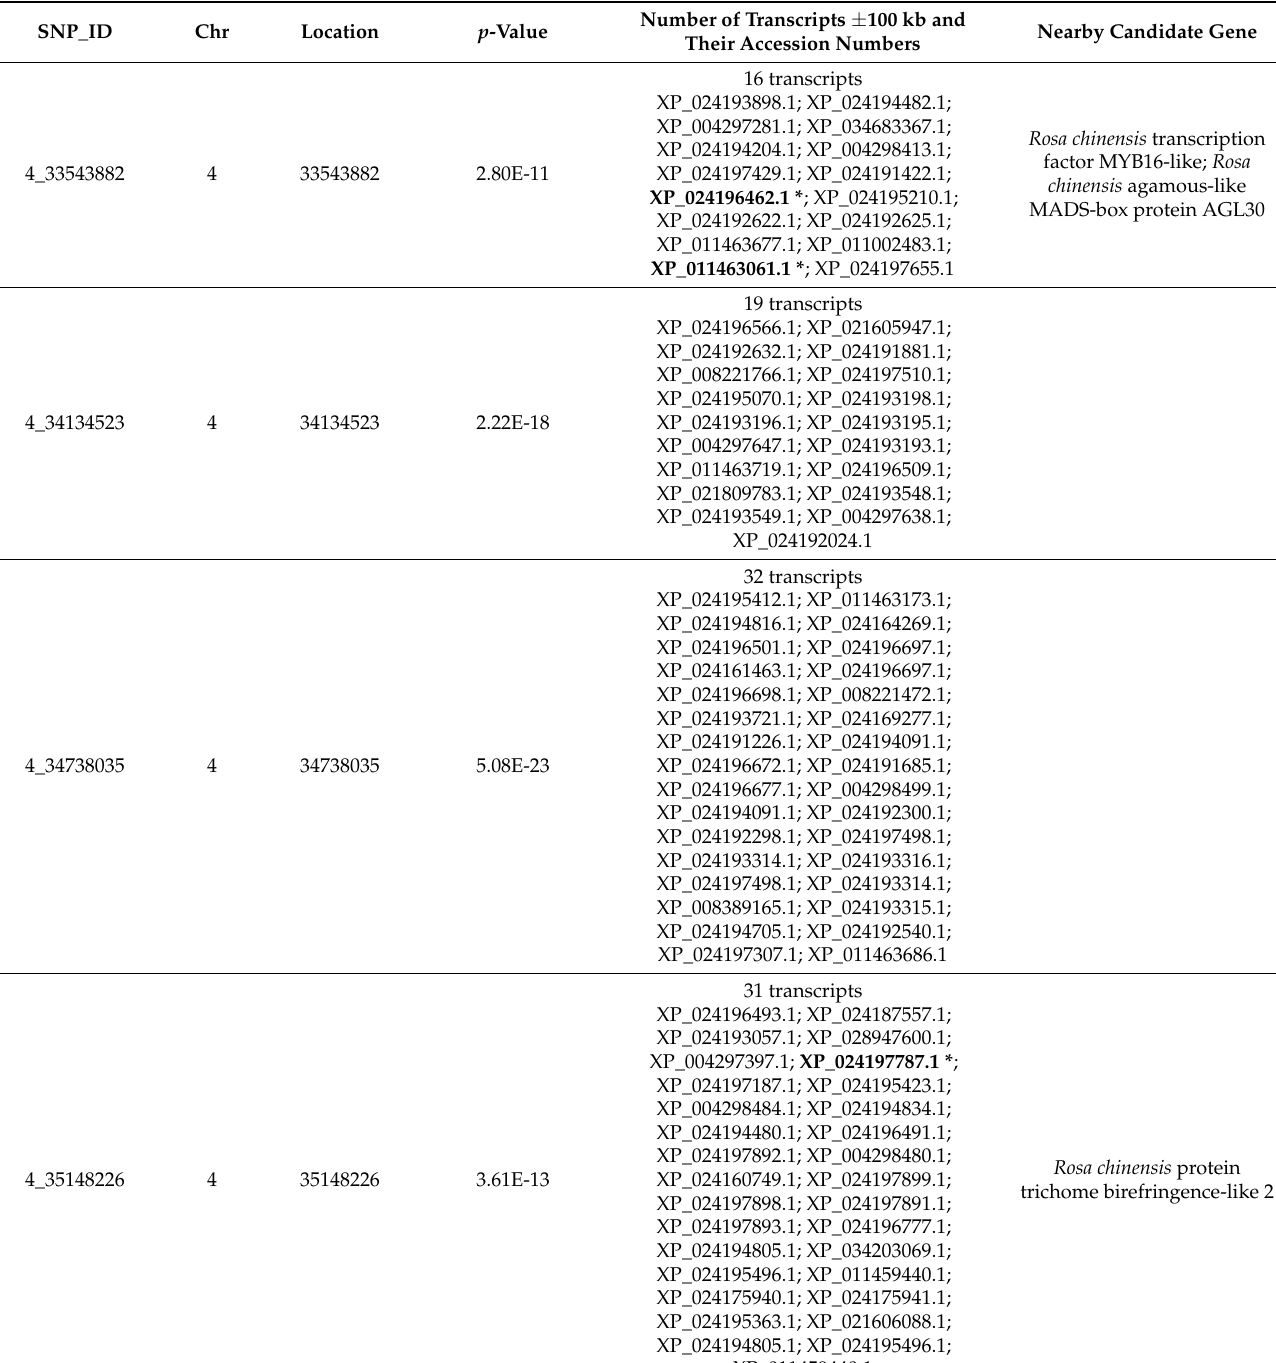
Table 2. Top SNPs associated with prickle phenotype using the FarmCPU model and associated transcripts and puta- tive candidate genes annotated and identified using the Blast2GO tool with BLASTp search against the non-redundant protein